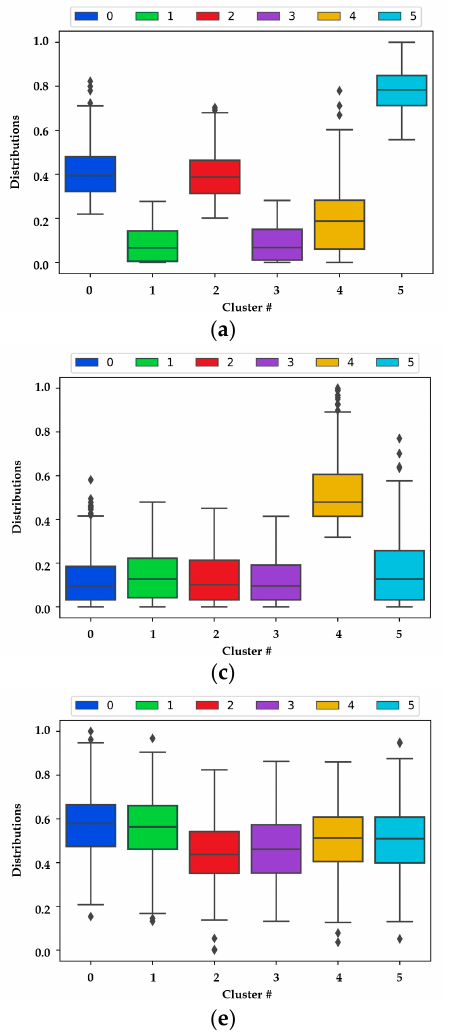
Figure 10. Boxplots of ( a ) VV; ( b ) VA; ( c ) PV; ( d ) DVP; and ( e ) DVC by clusters.